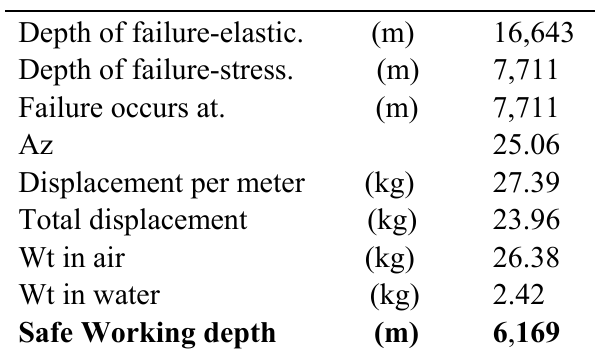
Table 3. Pressure tube specifications.